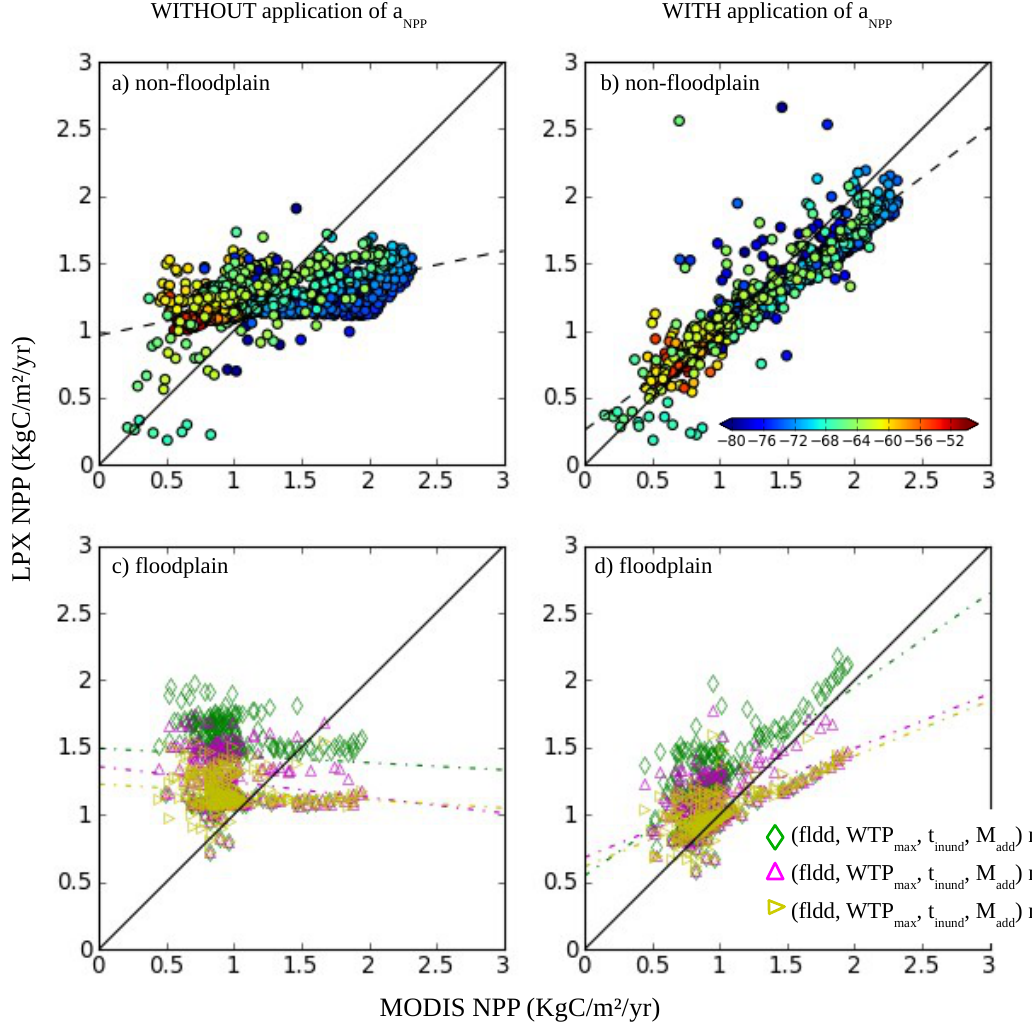
Fig. 3. LPX-simulated NPP vs. MODIS-derived NPP for non-floodplain (top line, a and b ) and floodplain ecosystems (bottom line, c and d ). The MODIS vs. LPX relationship is given without (left panels, a and c ) and with (right panels, b and d ) application of the a NPP scaling factor. a NPP was calibrated on non-floodplain ecosystems, which explains why the inclusion of a NPP is characterized by a strong improvement ( a : slope of 0.21 and R 2 of 0.31; b : slope of 0.75 with a R 2 of 0.85). For each panel, a dot corresponds to a grid cell where the considered ecosystem occupies more than 5.1% of the grid cell in both GLC2000 and LPX. The color pallet corresponds to the longitudinal localization (in ◦ W) of each grid cell. Results of three LPX simulations varying through the used fldd and the tree parameterizations (cf. Table 1) are plotted in the bottom panels.